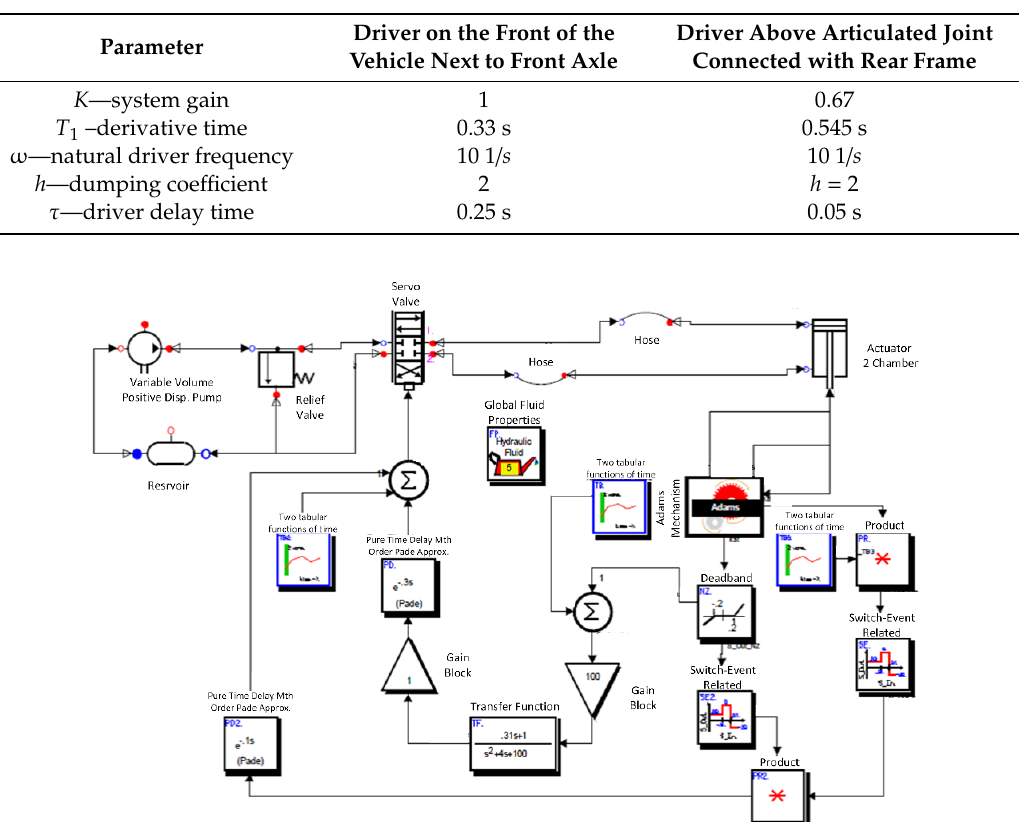
Figure 10. Diagram of vehicle control system developed in the MSC.Easy5 software.